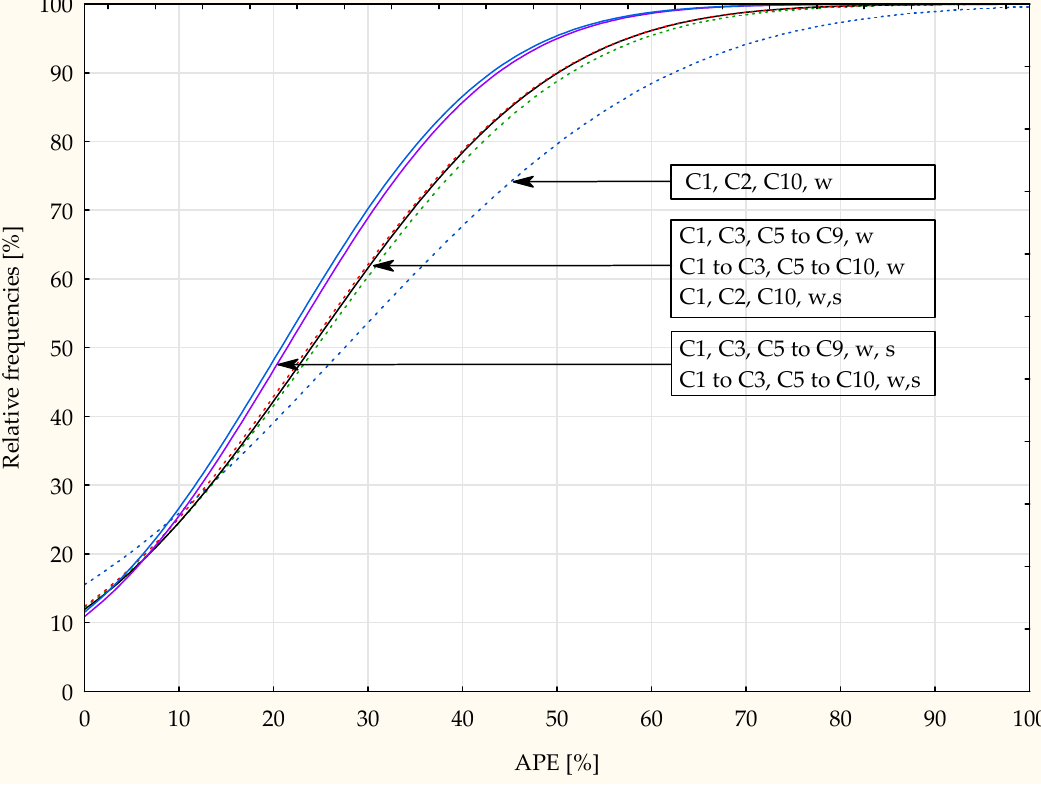
Figure 10. Distribution function of prediction errors of the total mass waste accumulation indicator.